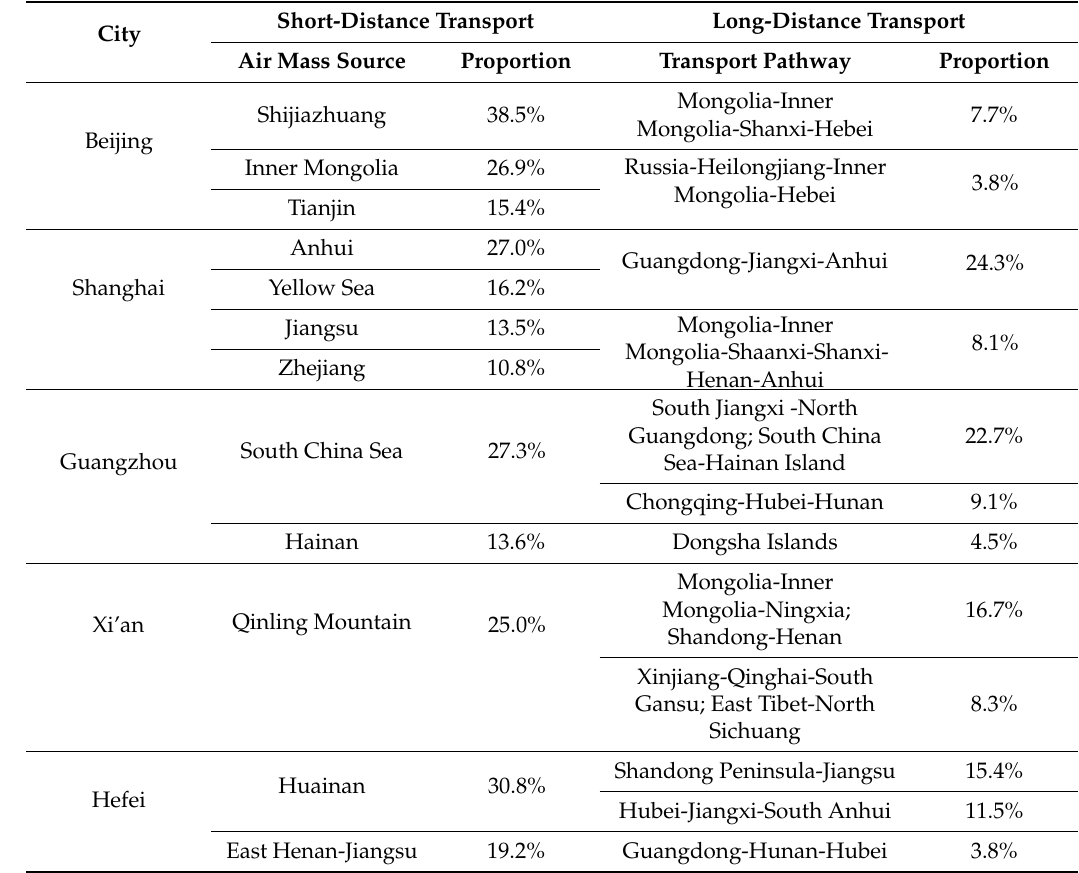
Table 3. Distribution characteristics of air mass backward trajectories during O 3